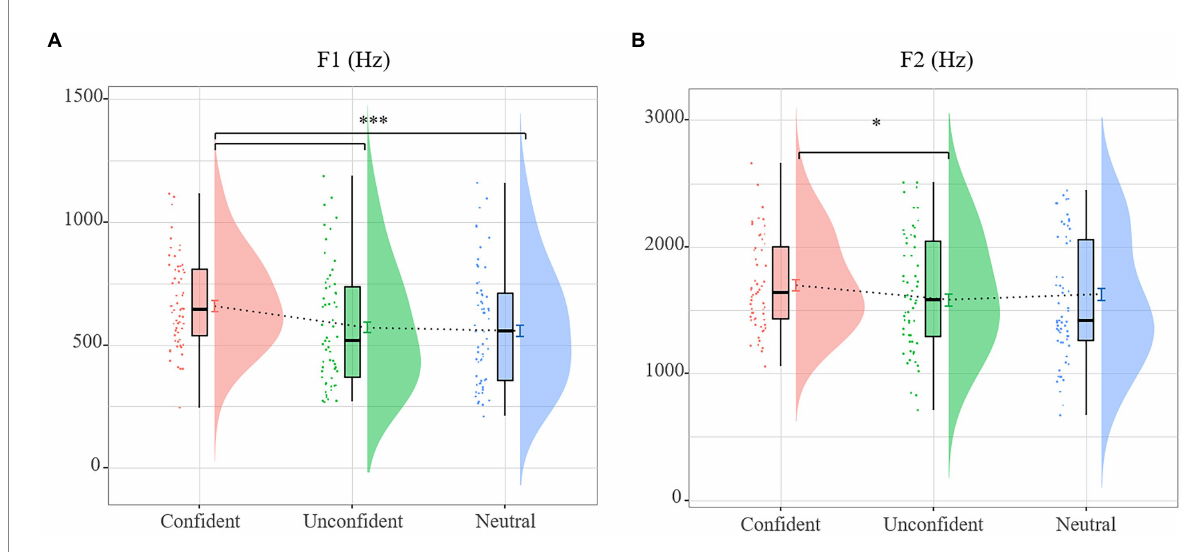
FIGURE 2 Raincloud plots for formant features showing the main effect of speaker confidence. (A) F1 and (B) F2 values per confidence level for all